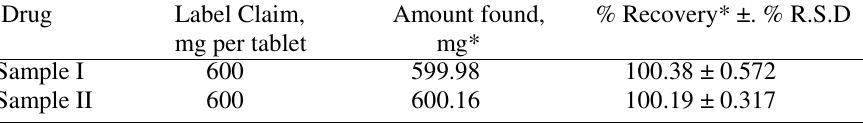
Table 2. Assay results of OXA in